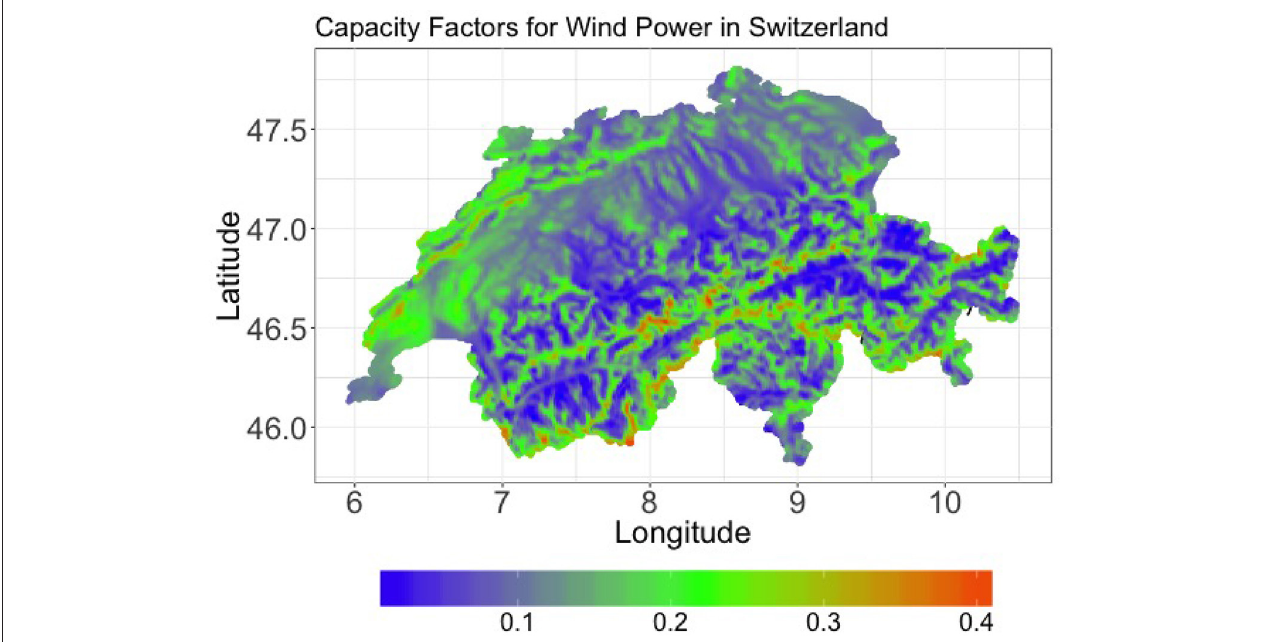
FIGURE 6 | Capacity Factors, defined as the ratio of produced power vs rated power, with a correction for down time due to maintenance or other